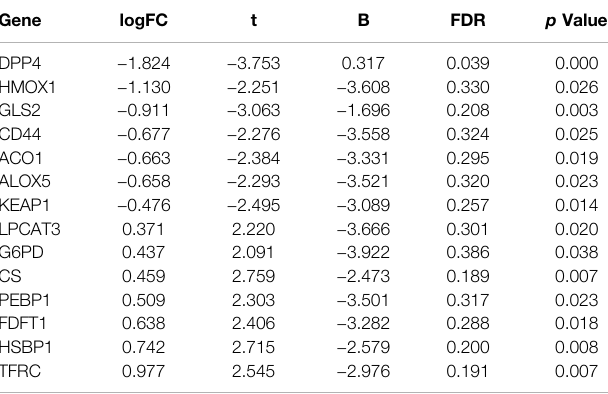
TABLE 1 | Signi fi cantly differentially expressed FRG in BC and BCBM